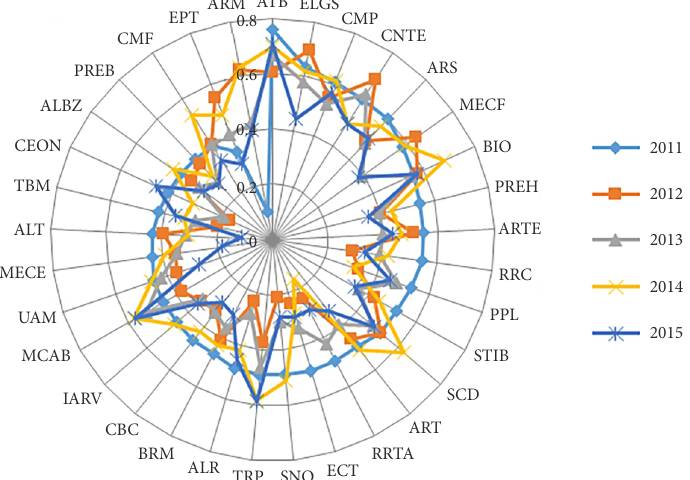
Figure 1. Companies’ performances trend during the analyzed